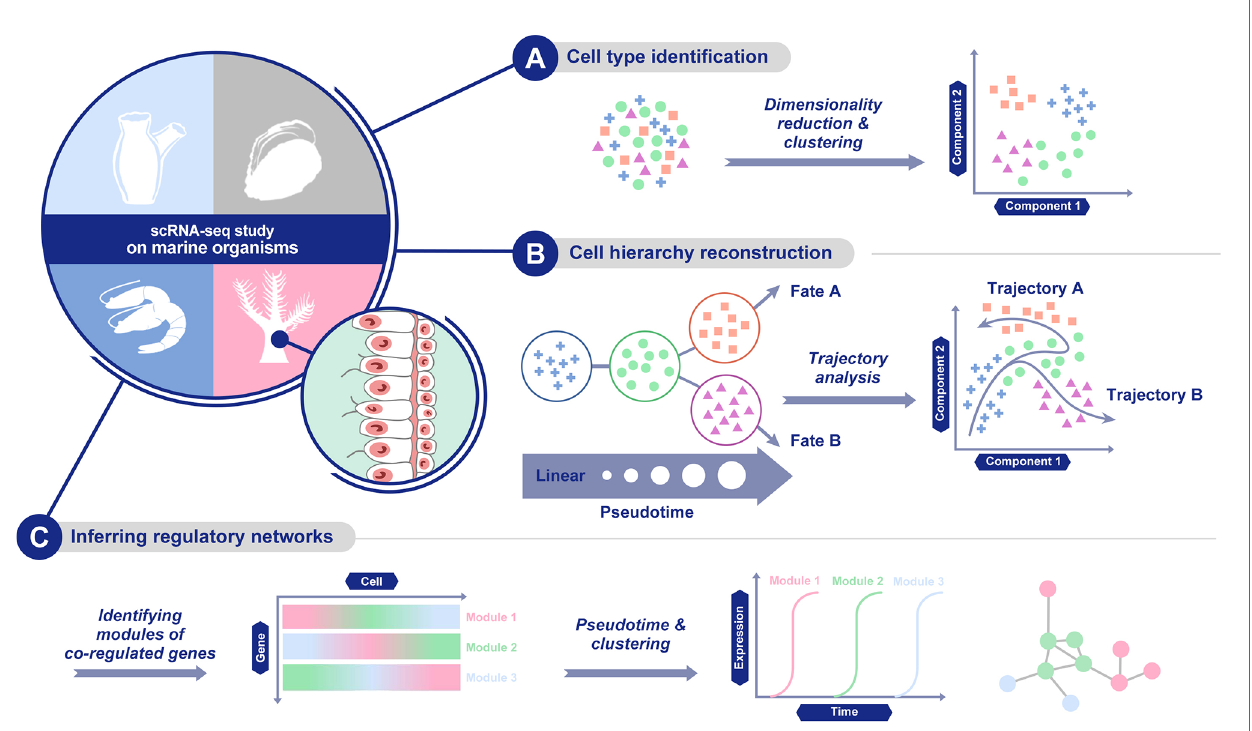
FIGURE 3 | Main scRNA-seq data analysis methods. (A) cell population characterization via dimensionality reduction and clustering; (B) cellular trajectory reconstruction by trajectory analysis; and (C) gene regulatory network